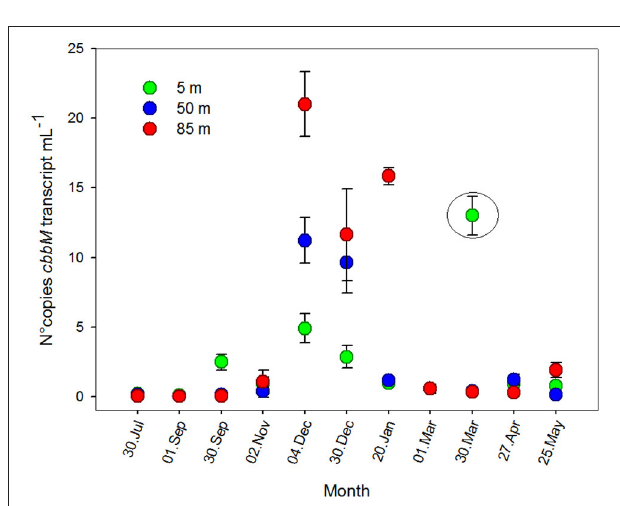
FIGURE 7 | RuBisCO form II transcription, presented as number of copies of cbbM transcripts mL − 1 ± standard deviation, during an annual cycle, at 5, 50, and 85m of depth, St.